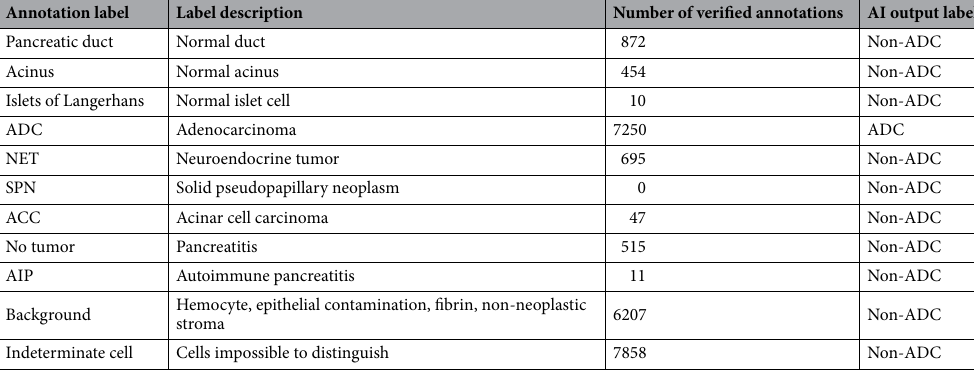
Table 2. Summary of annotation labels and model output